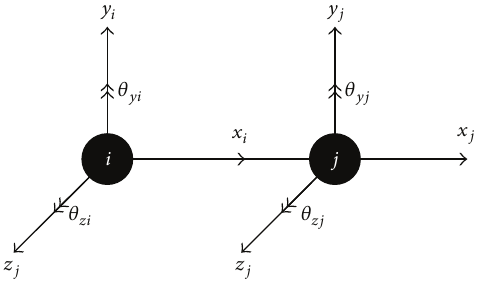
Figure 7: Reference frame of the typical beam